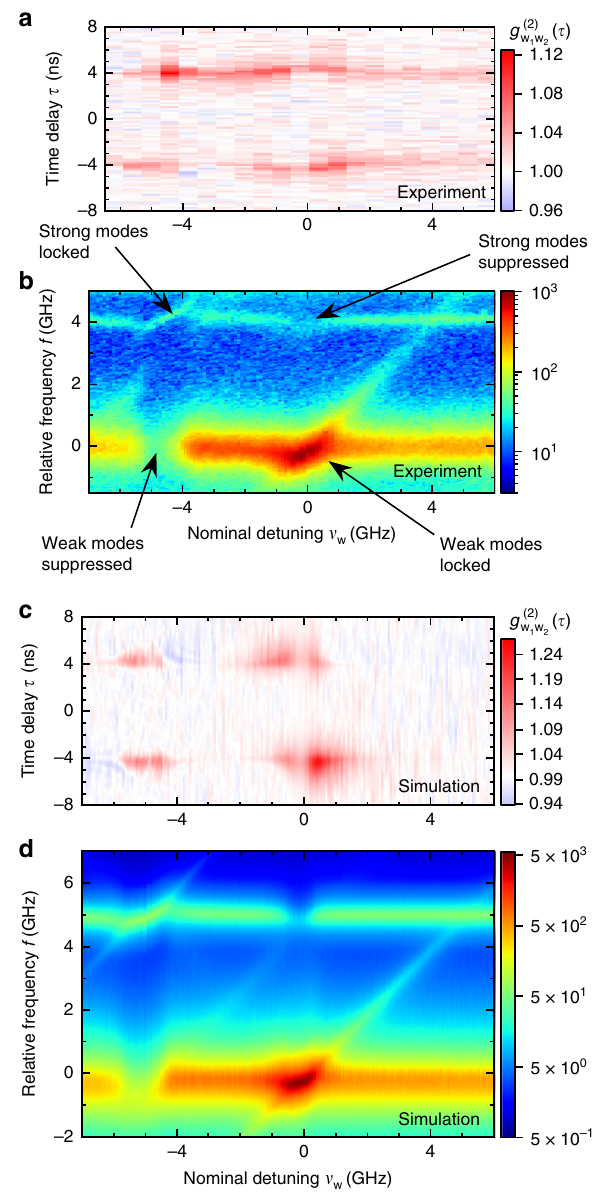
Fig. 6 Correlation and locking maps of two coupled micropillar